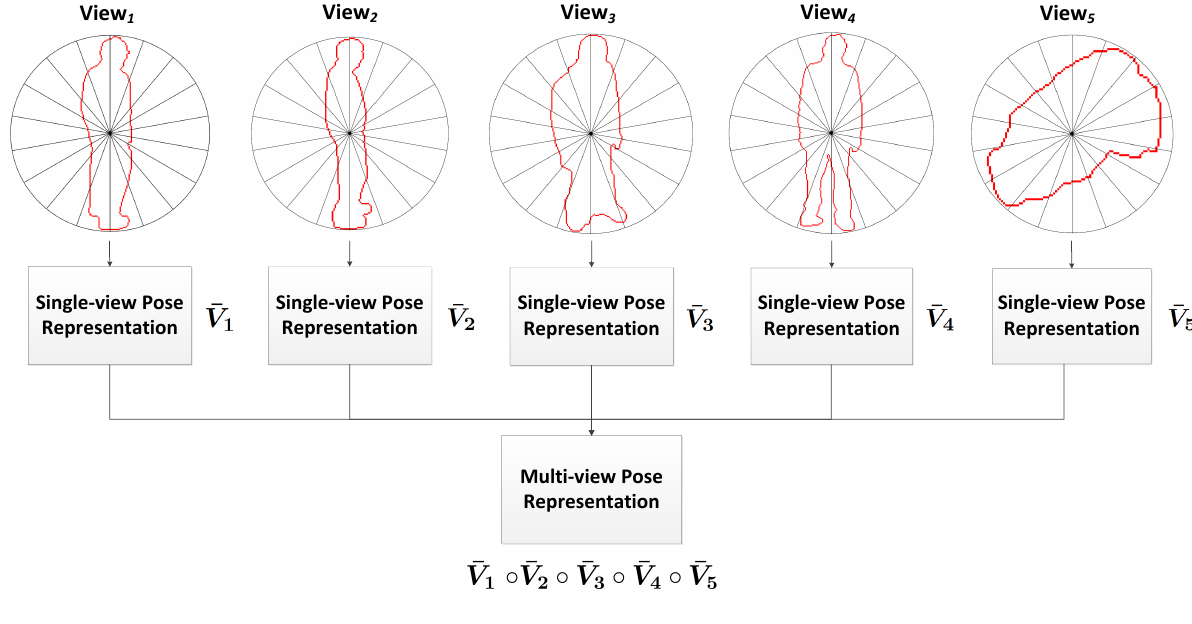
Figure 3. Overview of the generation process of the multi-view pose representation. This example shows a specific pose taken from the walk action class from the IXMAS